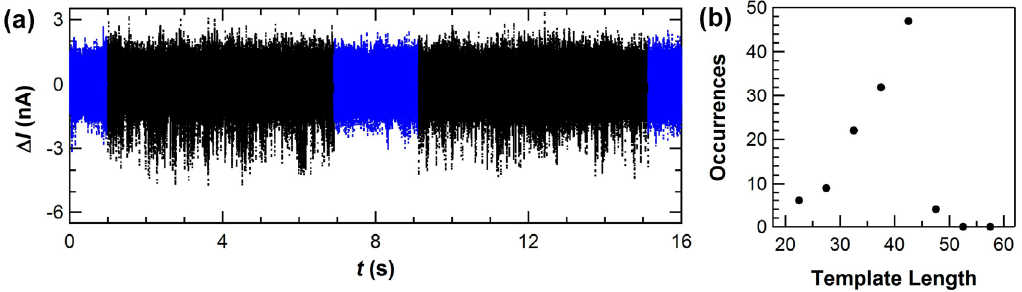
Figure 4. ( a ) Template concentrations below 5 nM introduced additional pauses ( blue ) in the records of KF activity. The pauses represent diffusional waiting times for template arrival and association. Each uninterrupted sequence of ∆ I ( t ) excursions ( black ) represents the processing of one template strand. ( b ) Distribution of apparent lengths observed using a low concentration of the homopolymer (dC) 42 template, as determined by counting the individual ∆ I ( t ) excursions in a 10-min data set containing 135 uninterrupted sequences.